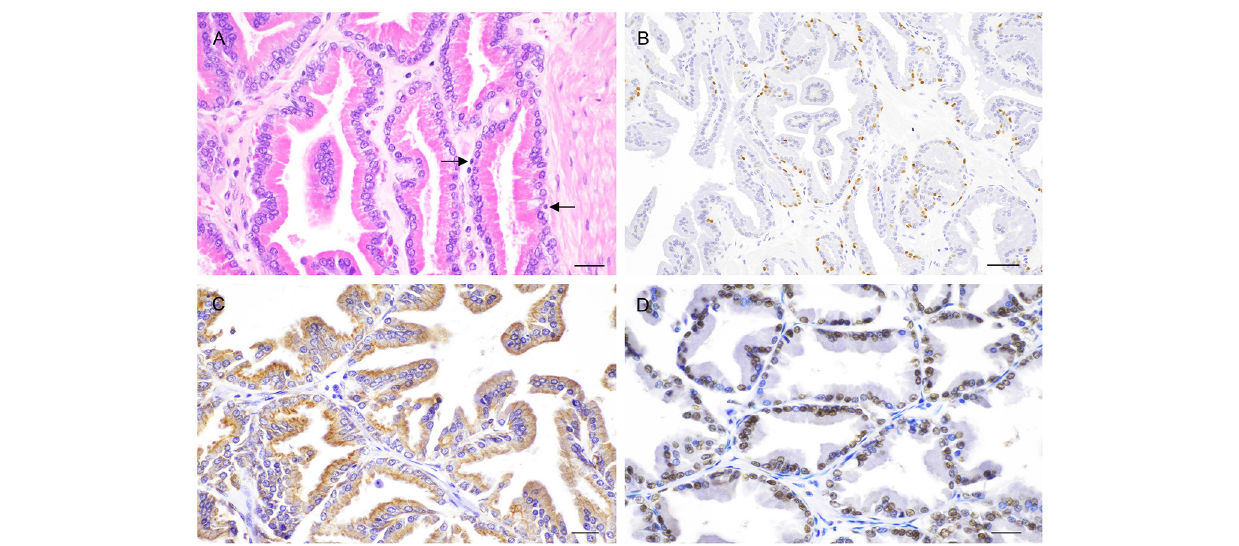
FIGURE 3 | Histological and immunohistochemical features of the normal canine prostate. (A) Tubuloalveolar gland lined by secretory columnar cells with low number of basal cells (arrows). Hematoxylin-eosin staining. Bar = 25 µ m. (B) Nuclear expression of p63 by basal cells. IHC. DAB chromagen. Meyer’s hematoxylin counterstain. Bar = 100 µ m (mouse monoclonal anti-mouse p63, Dako, 1:150). (C) Cytoplasmic expression of CK8/18 by columnar secretory cells. IHC. DAB chromagen. Meyer’s hematoxylin counterstain. Bar = 25 µ m (mouse monoclonal anti-human Ck8/18, Novocastra, 1:600). (D) Nuclear positive staining for androgen receptor (AR) by columnar secretory cells. IHC. DAB chromagen. Meyer’s hematoxylin counterstain. Bar = 25 µ m (rabbit polyclonal anti-human AR, Santa Cruz Biotech.,